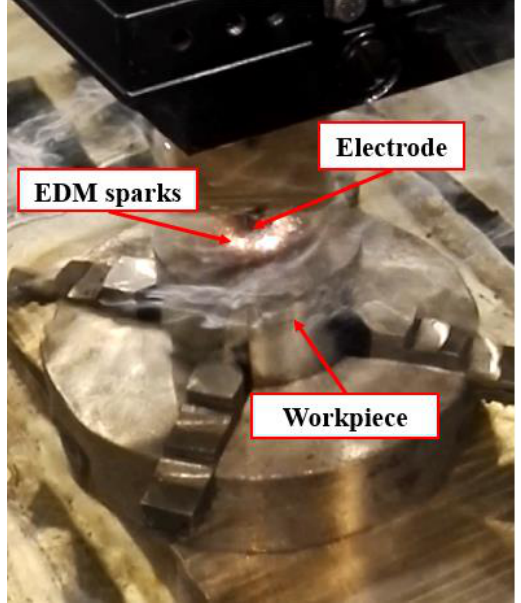
Figure 2. The EDM experimental setup.